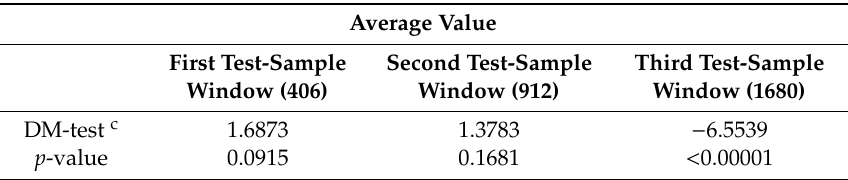
Figure 12. Real time comparison using Sharp’s-NUS0E3E PV panel ( a ) between the actual power and simulated NARX network ( b ) NARX voltage and current errors. Table 5. Results of the Diebold-Mariano (DM)